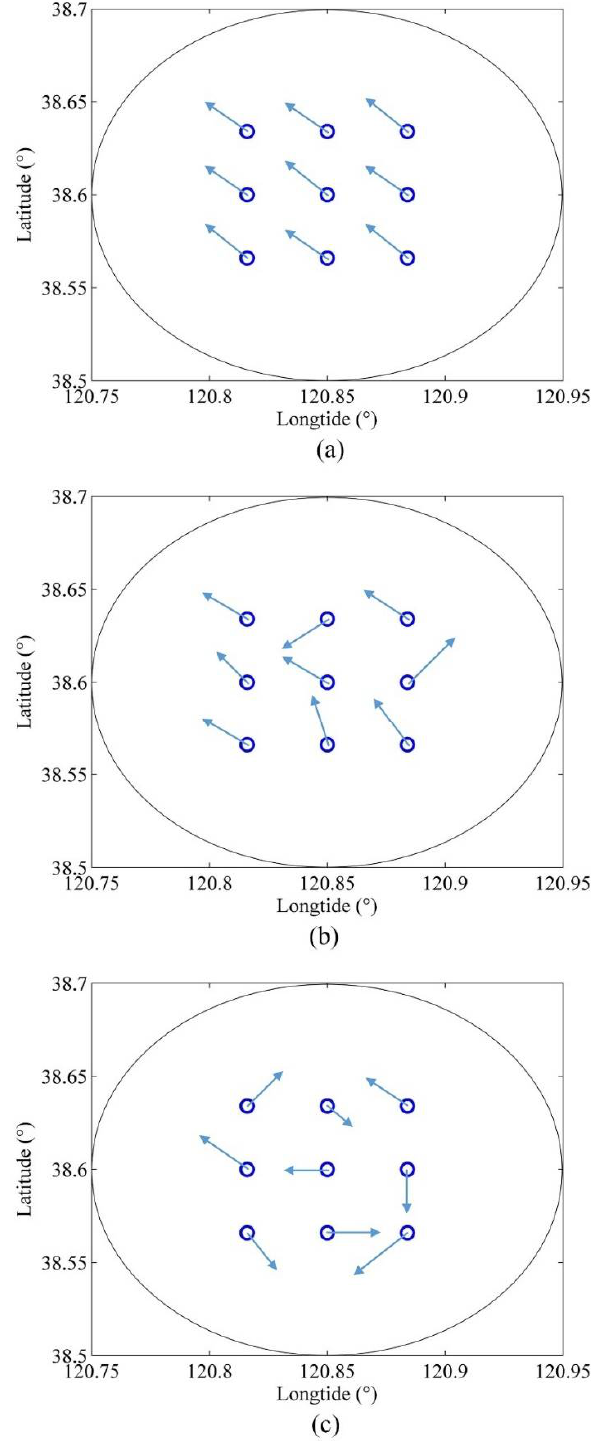
Figure 6. The three scenarios for the first simulated case study ( a ) Scenario 1; ( b ) Scenario 2; ( c ) Scenario 3.